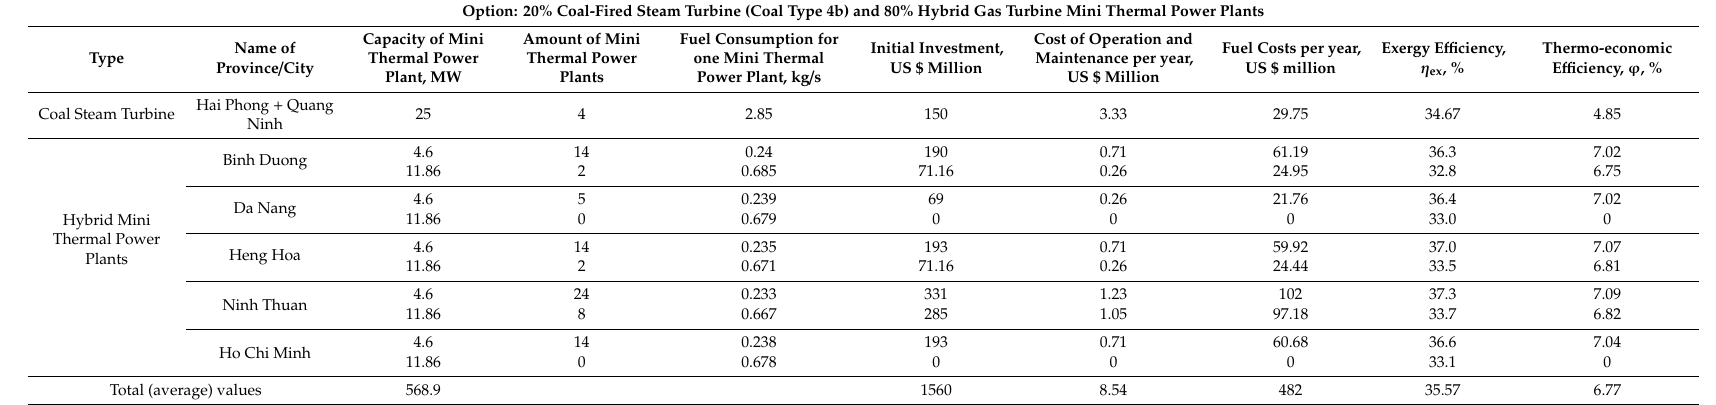
Table 2. Indicators of the best option for integrating mini thermal power plants into the energy system of the Republic of